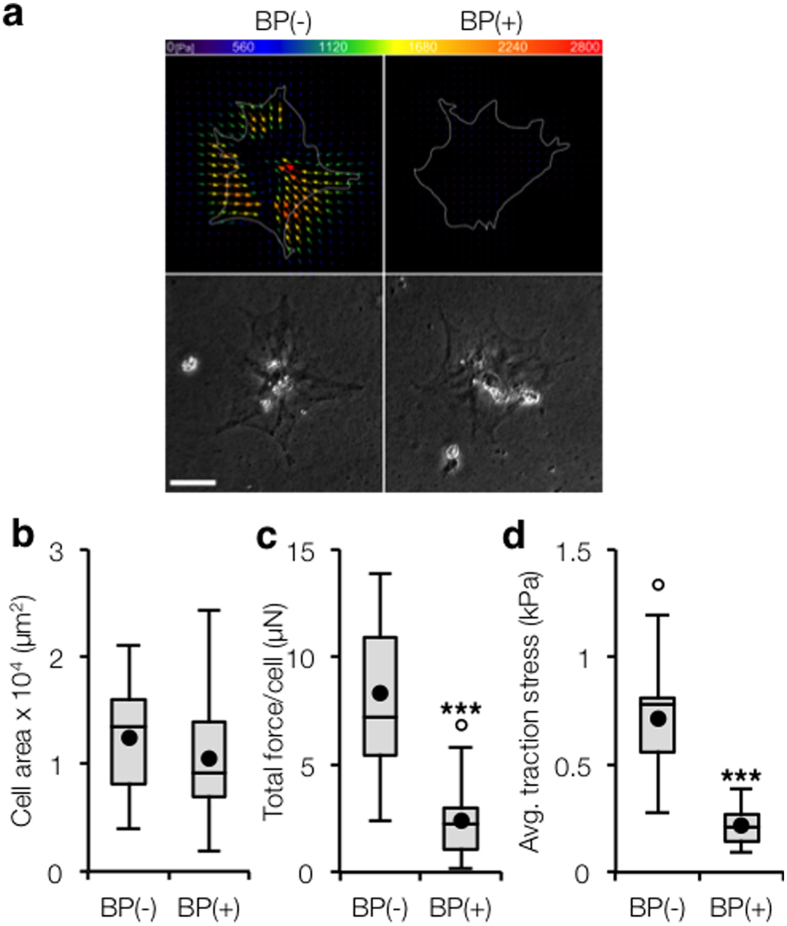
Inhibiting α-SMA does not alter stellate cell spread area but significantly reduces traction force generation.(a) Representative traction force vector maps and phase contrast images illustrating similar spreading but stronger tractions in BP(−) group. Scale bar: 50 μm. (b) Tukey box plot quantification of cell spread area (n > 12 cells per group). (c) Tukey box plot quantification of total force generated per cell (n > 12 cells per group). (d) Tukey box plot quantification of average traction stress (n > 12 cells per group). ***P < 0.001.